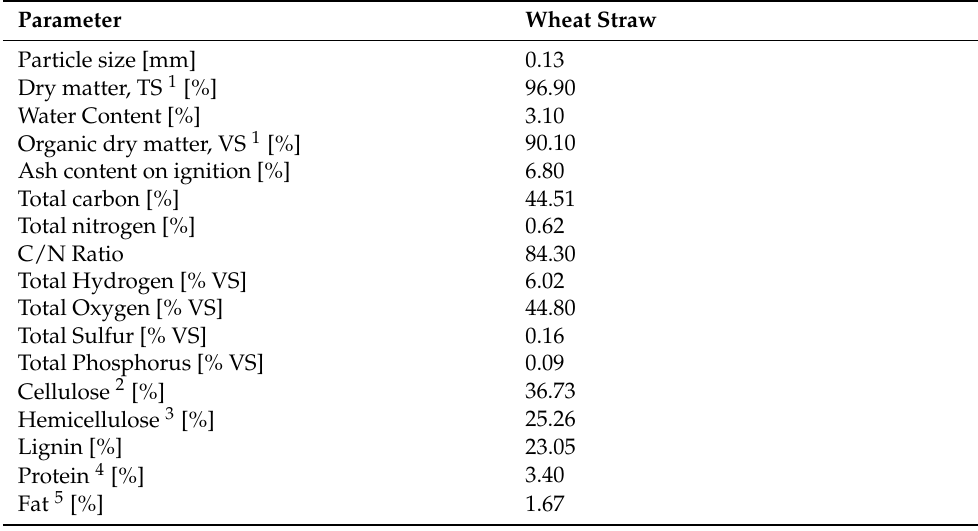
Table 1. Composition of wheat straw, determined by total solids = dry weight (TS), volatile solids = organic dry weight (VS), wood sugar, and elemental analyses, as well as TXRF methodology (transmission X-ray fluorescence